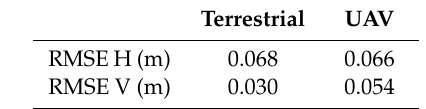
Table 3. RMSE of Prang, computed on 20 checkpoints for the terrestrial and UAV point clouds.